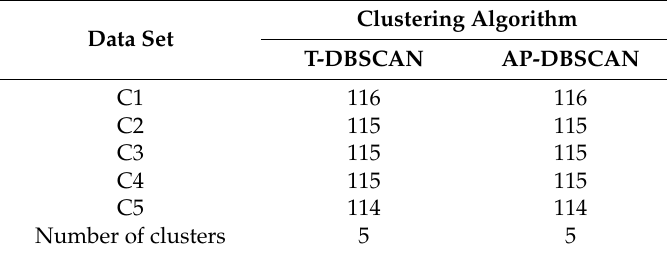
Table 3. Comparison of calculated data by two methods for buried sensors.